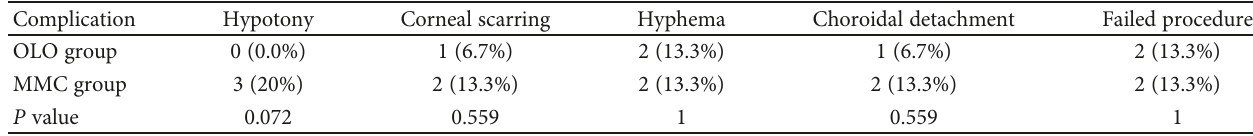
Table 4: Frequency of postoperative complications in both groups.